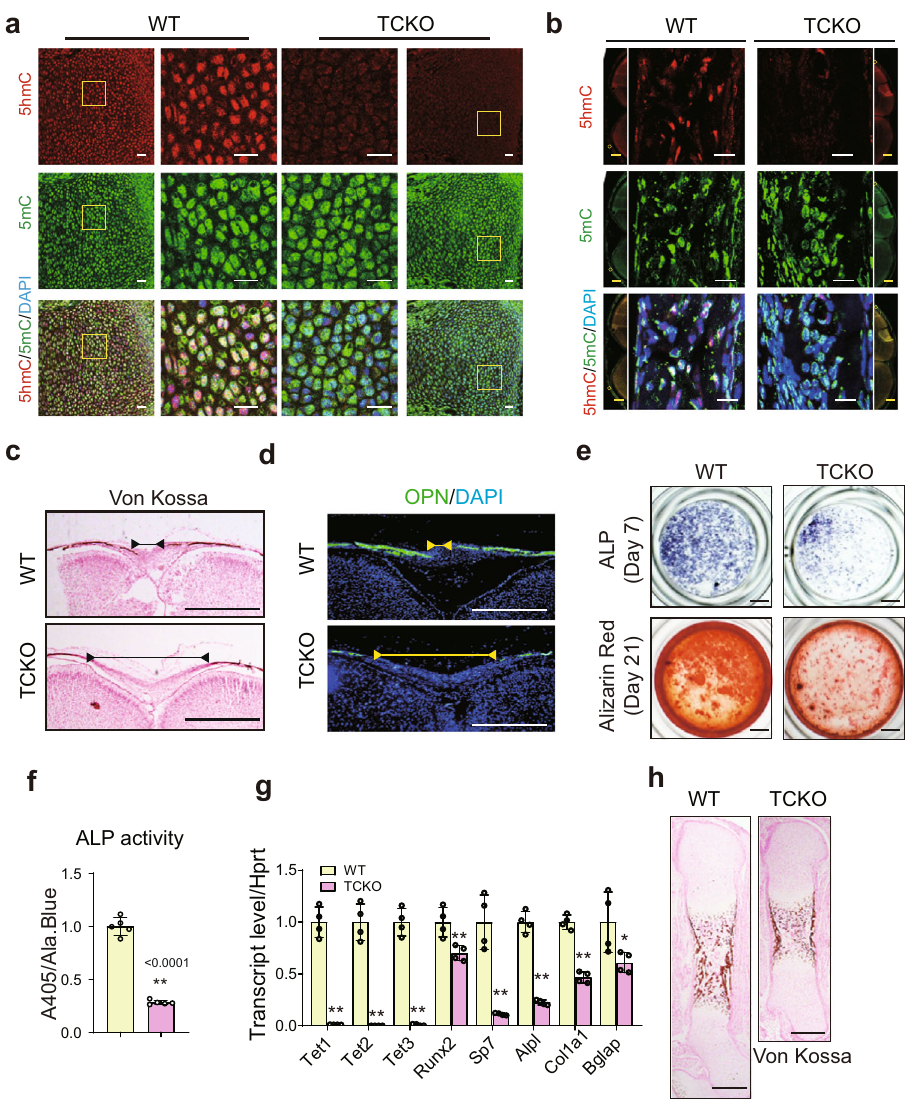
Fig. 2 | Loss of Tet family genes impairs bone formation. a , b Immuno fl uorescence assay of 5mC and 5hmC in limb at embryonic day 16.5 (E16.5) ( a ) and calvarial bone atP0 ( b ) of WT and TCKO mice. Scale bar=20 μ m or 500 μ m. Representative images for three independent samples. The images in the center were zoomed in from the fl anking images. c Representative images of Von- kossa staining in the cranial bones from WT and TCKO mice at P0. Scale bar= 500 μ m. d Immuno fl uorescence of bone formation marker Osteopontin (OPN) in thecranialbonesfromWTandTCKOmiceatP0.Scalebar=500 μ m.Thelineswith endpoint indicated the unmineralized region in the calvarial bone. Representative images for three independent samples. e ALP staining and Alizarin red S staining